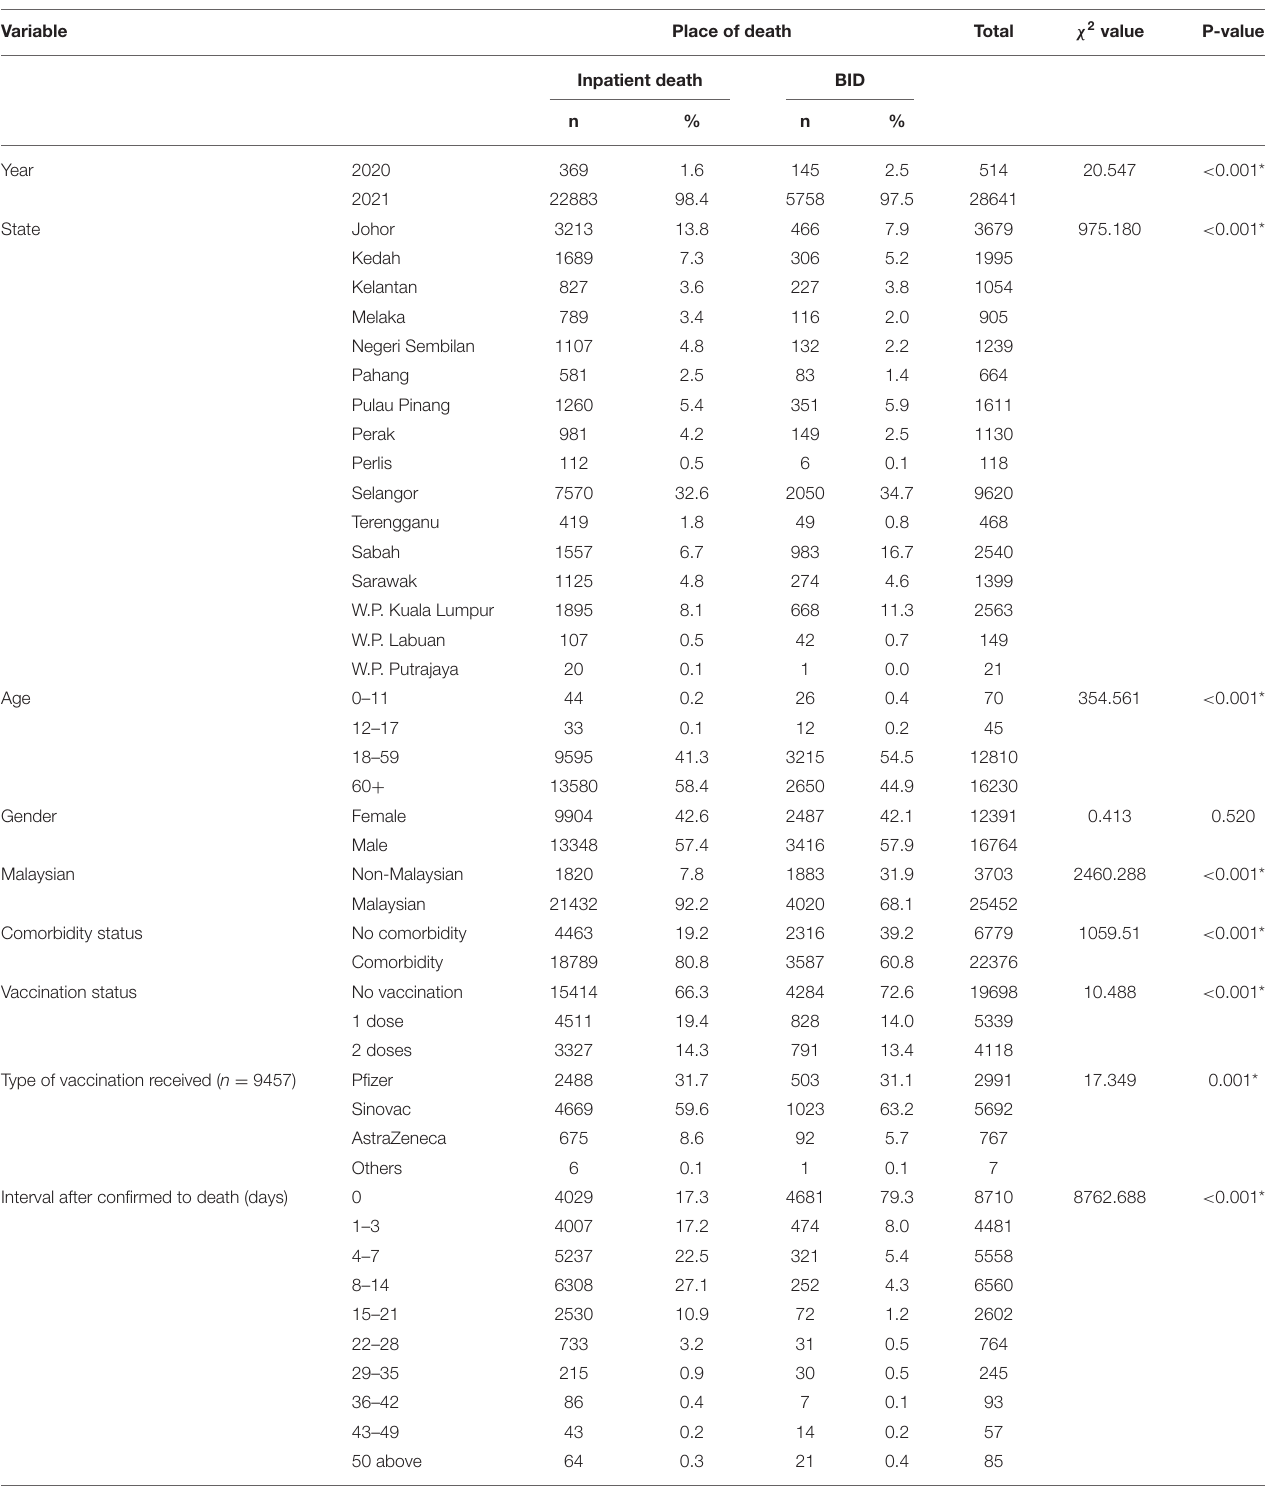
TABLE 2 | Comparison characteristics of mortality cases between inpatient death and brought–in–dead (BID).